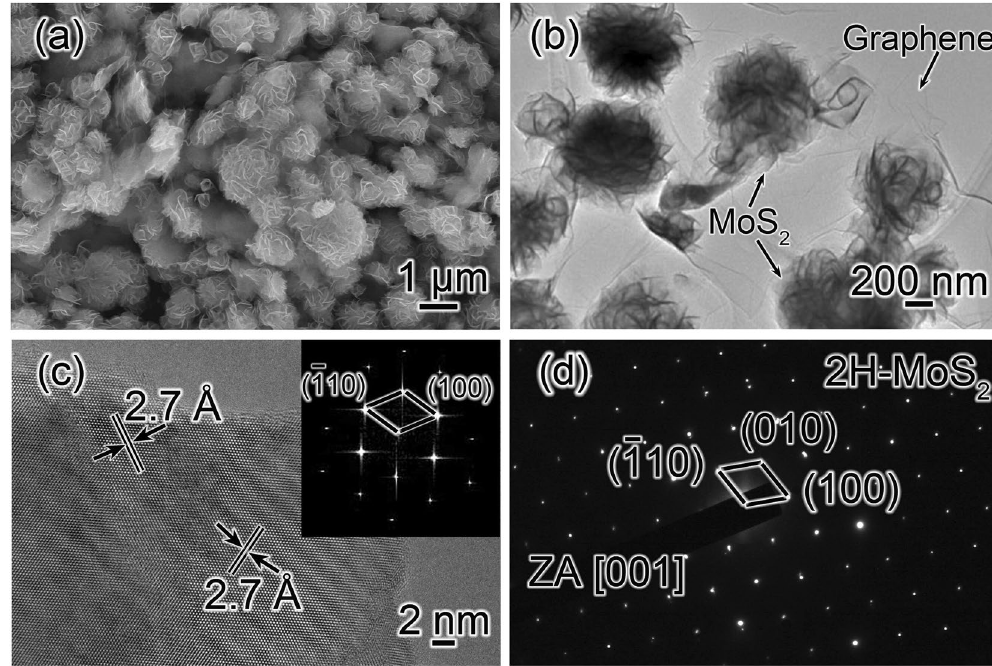
Figure 1. ( a ) SEM and ( b ) TEM images of the MoS 2 /graphene products. ( c ) HRTEM image and ( d ) SAED pattern of an individual MoS 2 nanosheet. The inset of ( c ) is the corresponding FFT pattern of the HRTEM